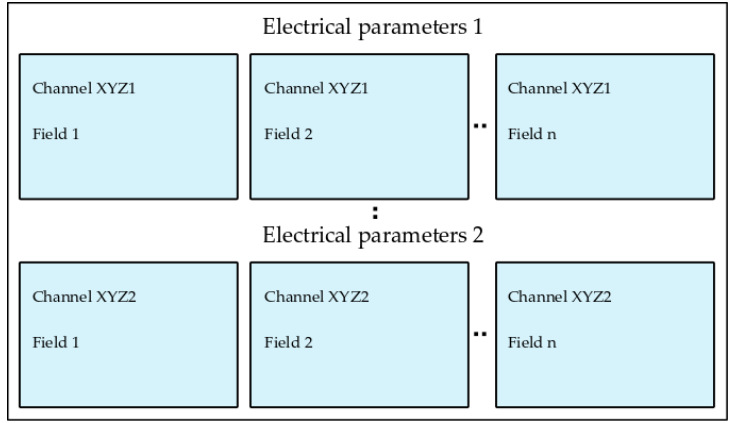
Figure 7. User interface design for web application.